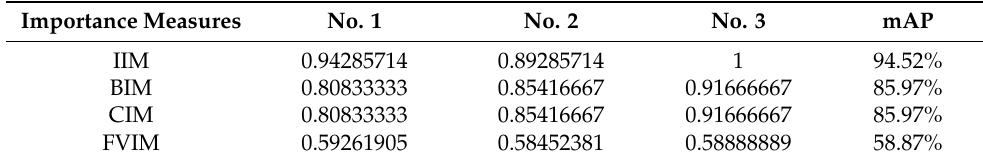
Table 7. The mAP values of four IM